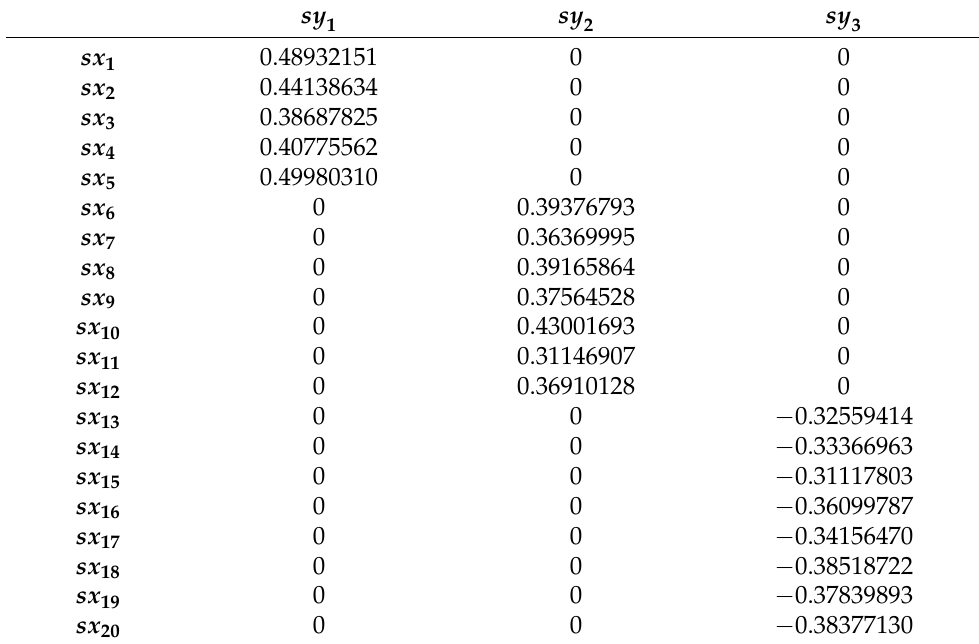
Table 15. Loading matrix A with the DisjointTuckerALS algorithm for simulated data.